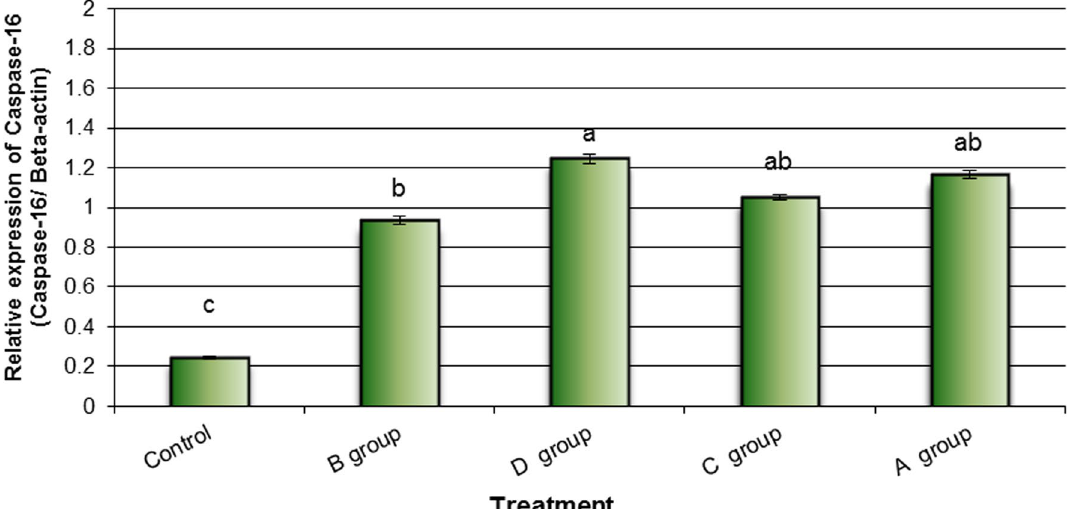
Fig. 1 The expression alterations of Caspase-16 gene in tissues of the insects treated with different bacterial bio‑insecticides. Data are displayed as mean SEM. Within tissues, mean values with dissimilar superscript letters showed a statistically significant difference (a: P0.01, b: P0.05)